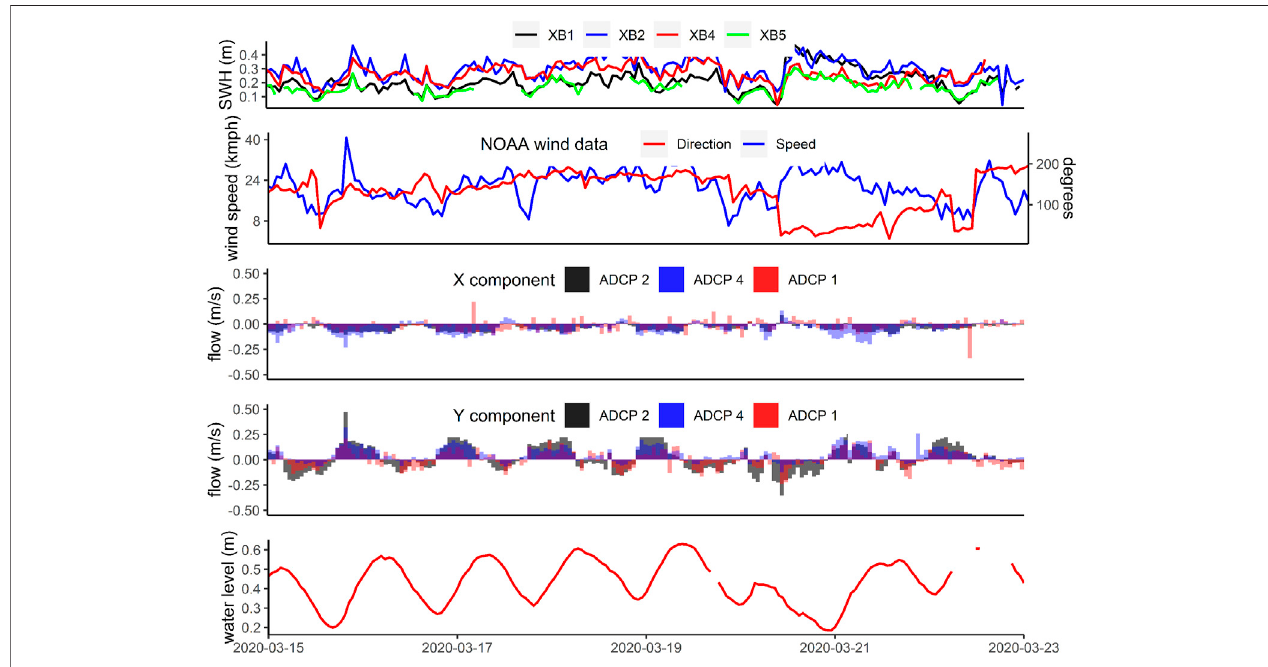
FIGURE 9 | Signi fi cant wave heights (H 2 ) at XB1, XB2, XB4, and XB5; NOAA wind speed and direction; ADCP1 (upward-looking, depth averaged), ADCP2 (side- looking, averaged over 20 m across bins 10 – 20), ADCP4 (side-looking but different model, averaged over 2 m across bins 10 – 20) fl ow direction and velocity in X and Y components; and CTD1 water level.SubplotCand D arethe Cartesian coordinate componentsof fl ow withthe X componentcorrespondingto east/west fl ow. Positive values in subplot C indicate fl ow towards the east while positive values for subplot D indicate fl ow to the